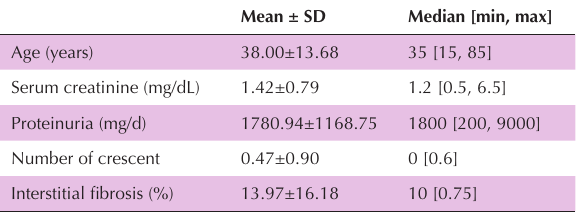
Table 1. Demographic information